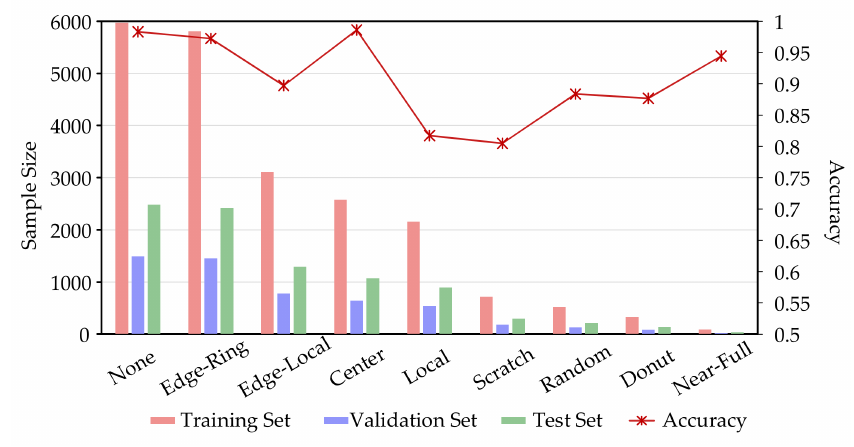
Figure 2. Distribution of the WM-811K dataset and classification accuracy of